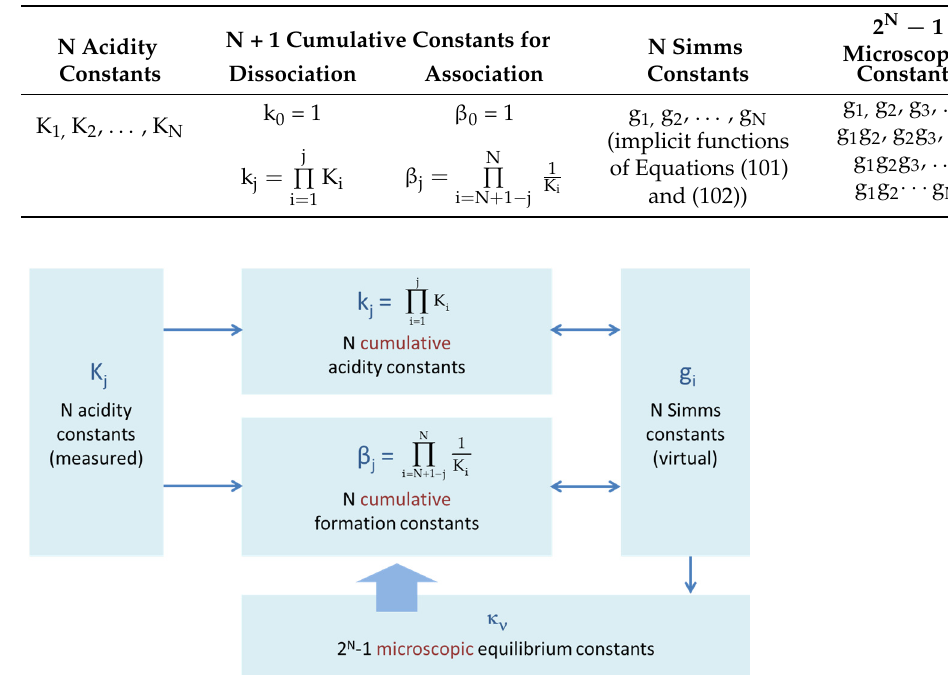
The difference between strong and weak acids is summarized in Table 5. Table 5. Strong vs. weak acids (greatly simplified). Strong Acid